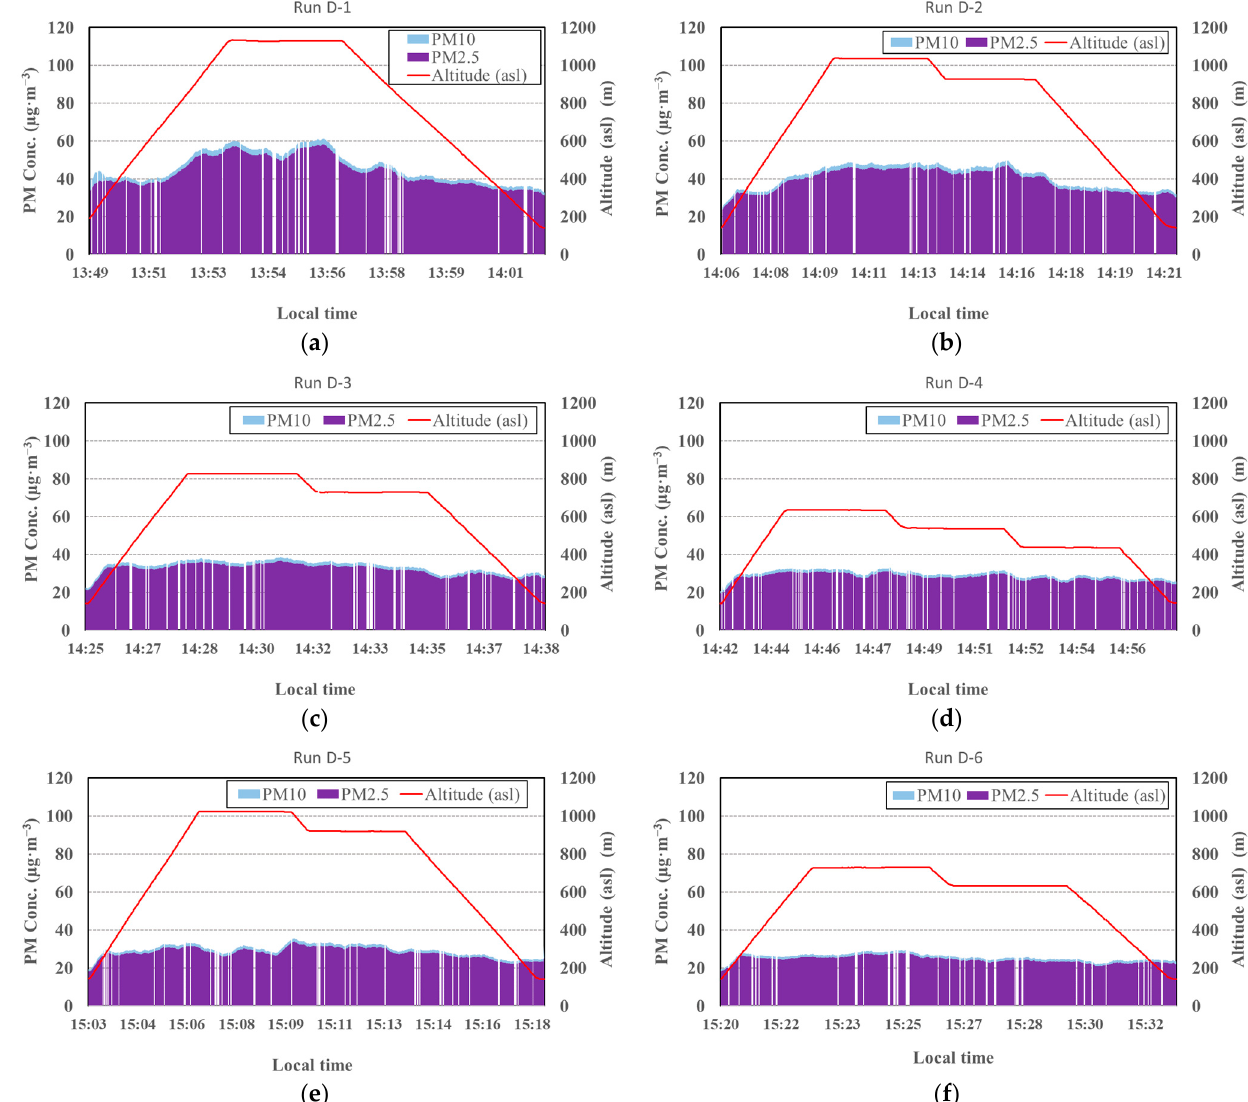
Figure 9. Time series variation of drone-measured PM 10 and PM 2.5 concentrations on 26 February 2020 (Runs D-1 to D-6) at Nabeyama site. Red lines show the altitude (asl) of flight. Flight pattern of ( a – f ) was Protocol A (i.e., “hovering”).